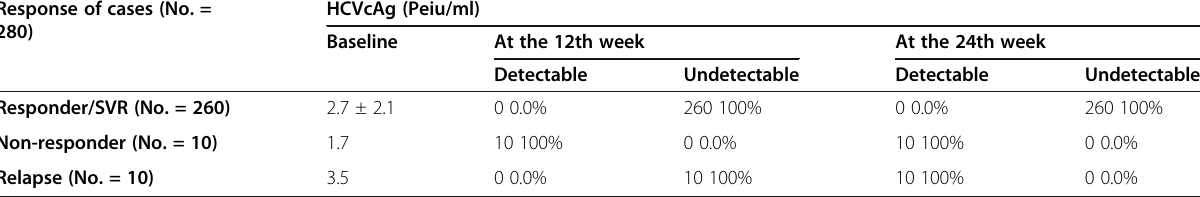
Table 6 HCVcAg at baseline, the 12th week, and the 24th week regarding treatment response Response of cases (No. =